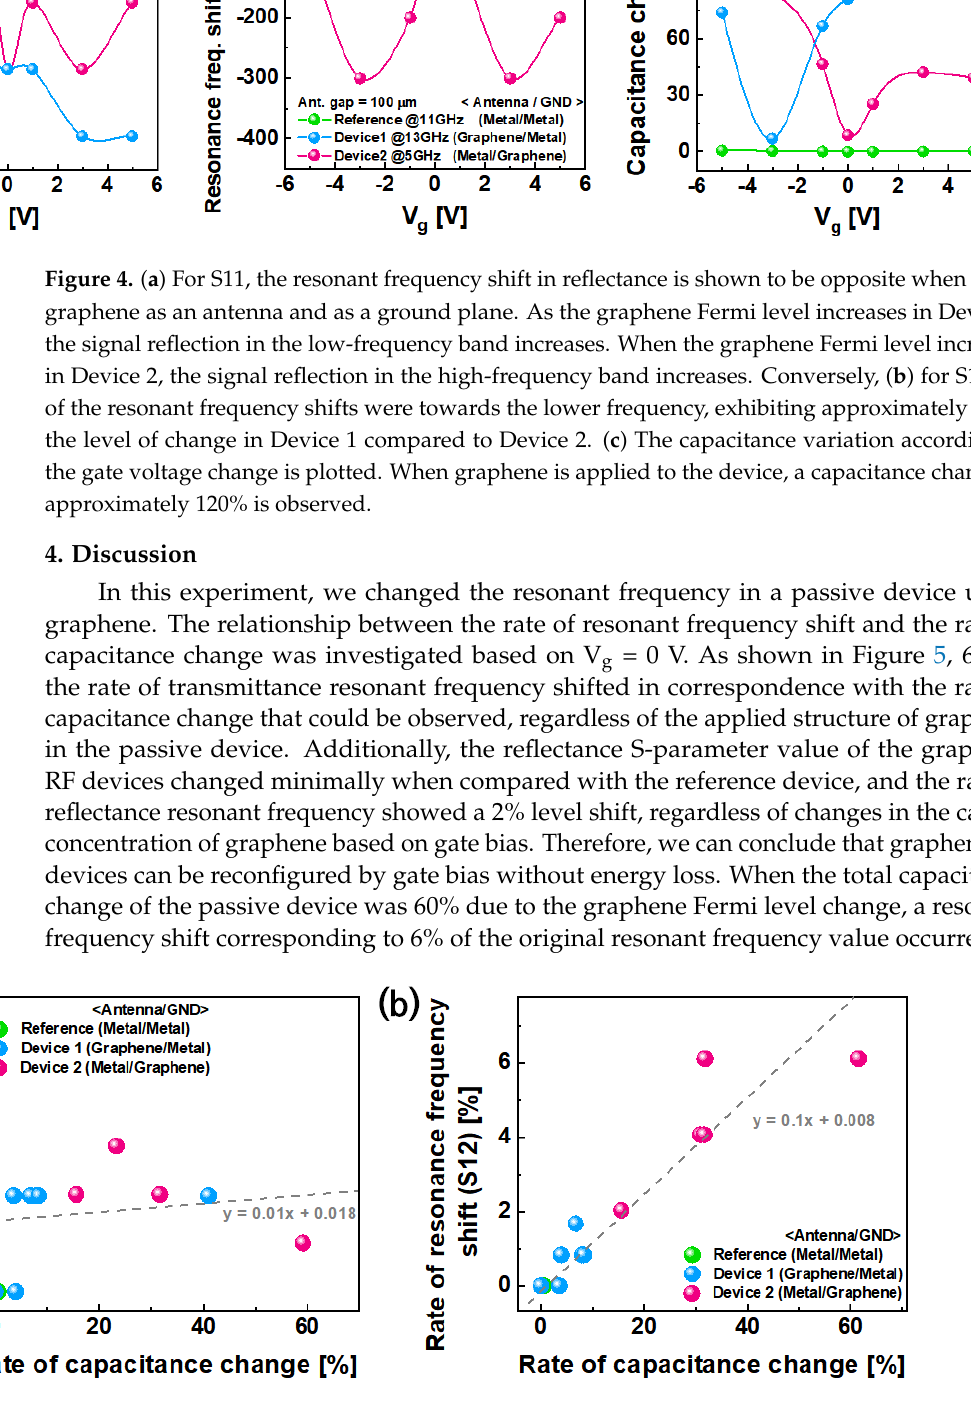
Figure 5. ( a ) Analysis of the relation between reflectance resonant frequency shift and graphene Fermi level change. ( b ) Analysis of the relation between transmittance resonant frequency shift and Fermi level change. ( b ) Analysis of the relation between transmiance resonant frequency shift and graphene Fermi level change. graphene Fermi level